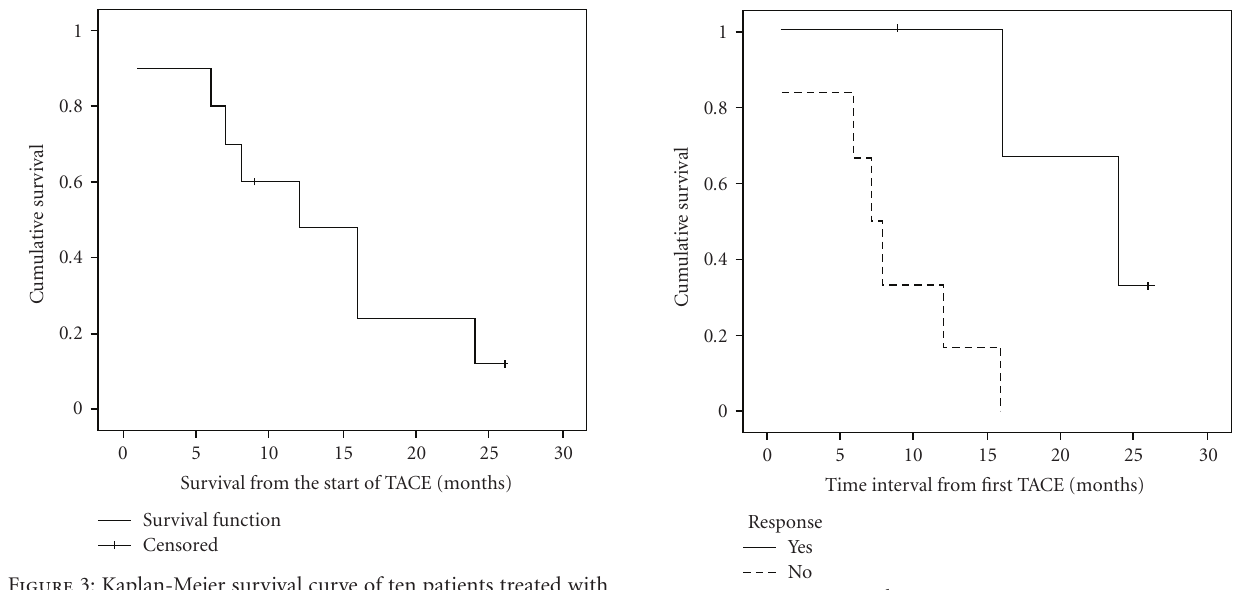
Figure 3: Kaplan-Meier survival curve of ten patients treated with TACE.